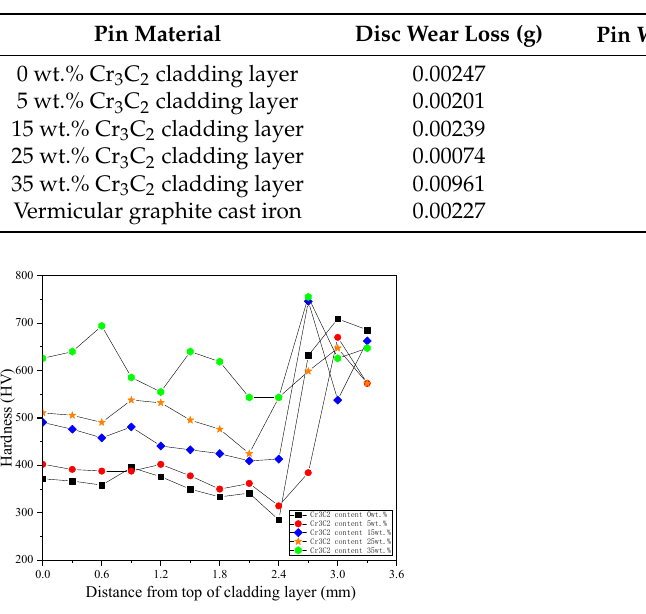
Figure 7. Microhardness of the cladding layers with different Cr 3 C 2 content.